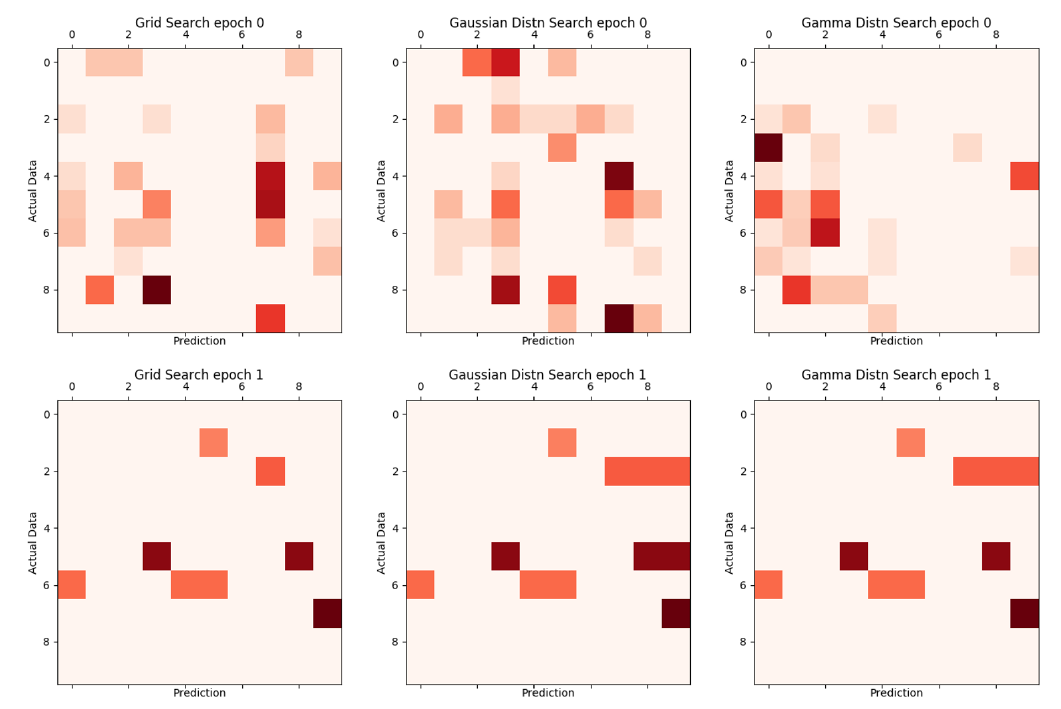
Figure 13. Proposed comparison of grid search, Gaussian distribution search, and Gamma distribution